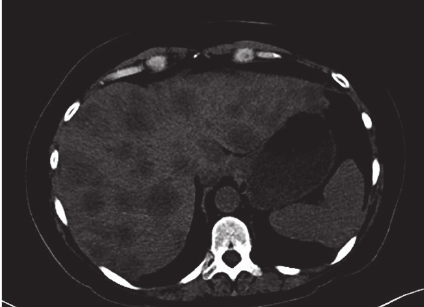
Figure 2: CT scan of the abdomen at the time of recurrent disease demonstrated innumerable lesions in the